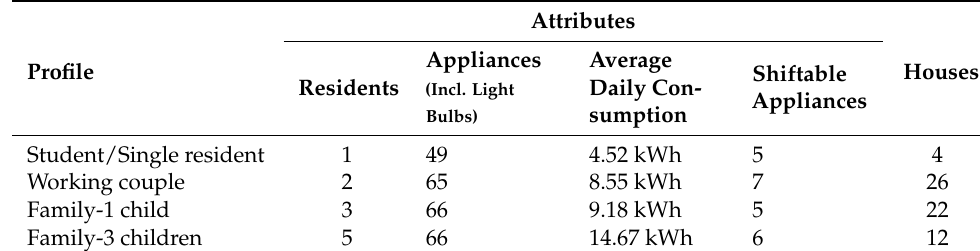
Table 2. Simulated Houses Portfolio.